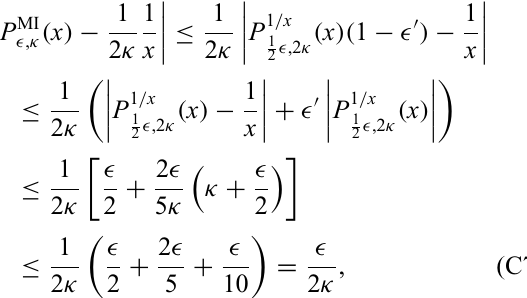
/ x ( x ) , (b) P rect ( x ) , and (c) P MI (cid:14) (cid:14) , κ 1 (cid:14) ,2 κ 2 ( x ) , is a degree-77 , κ